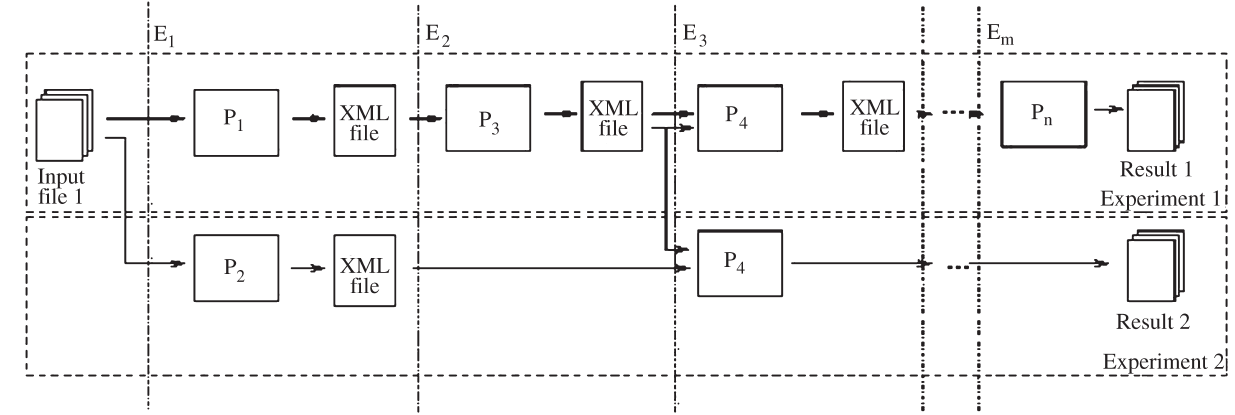
Figure 2 - GenFlow schema for molecular biology